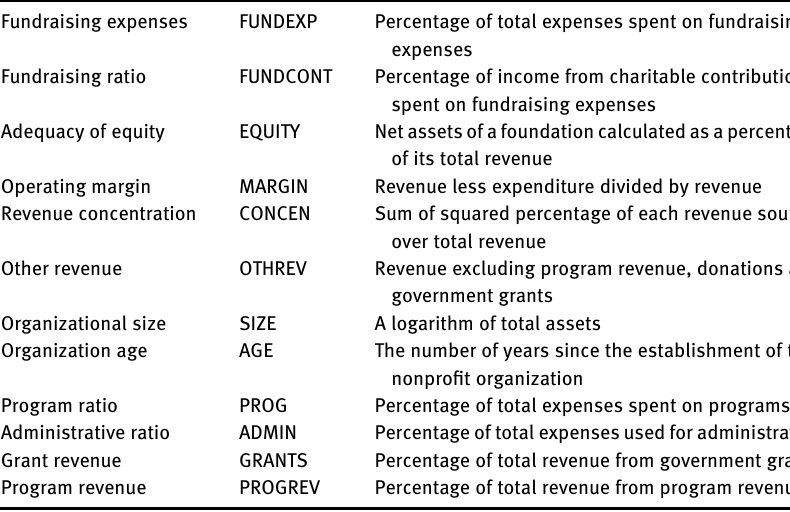
Table  : Control variable de fi